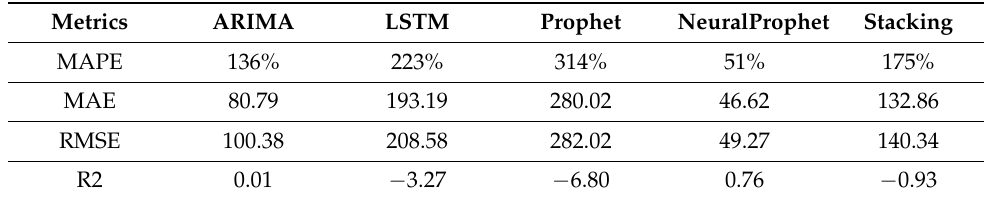
Figure 6. Comparison between actual and prediction for the next 7 days. Table 1. Evaluation metrics for the 4 models.